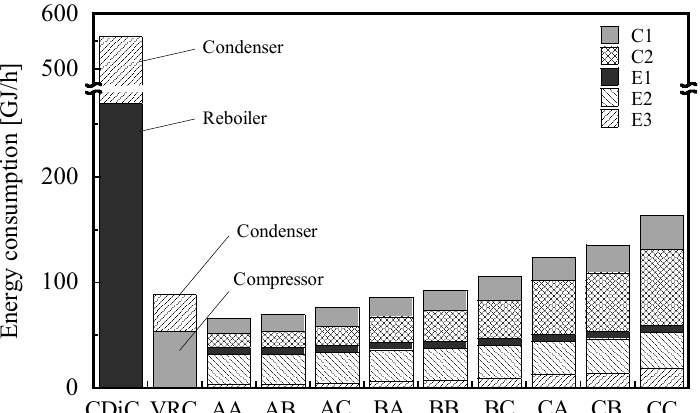
Figure 4. Energy consumptions of the two-stage membrane process with various combinations. C1 and C2 are compressors. The compressor duties are converted to primary energy. E1 is a heater; E2 and E3 are coolers. The energy consumption of CDiC includes the condenser and reboiler duties. The energy consumption of VRC includes the condenser and compressor duties .